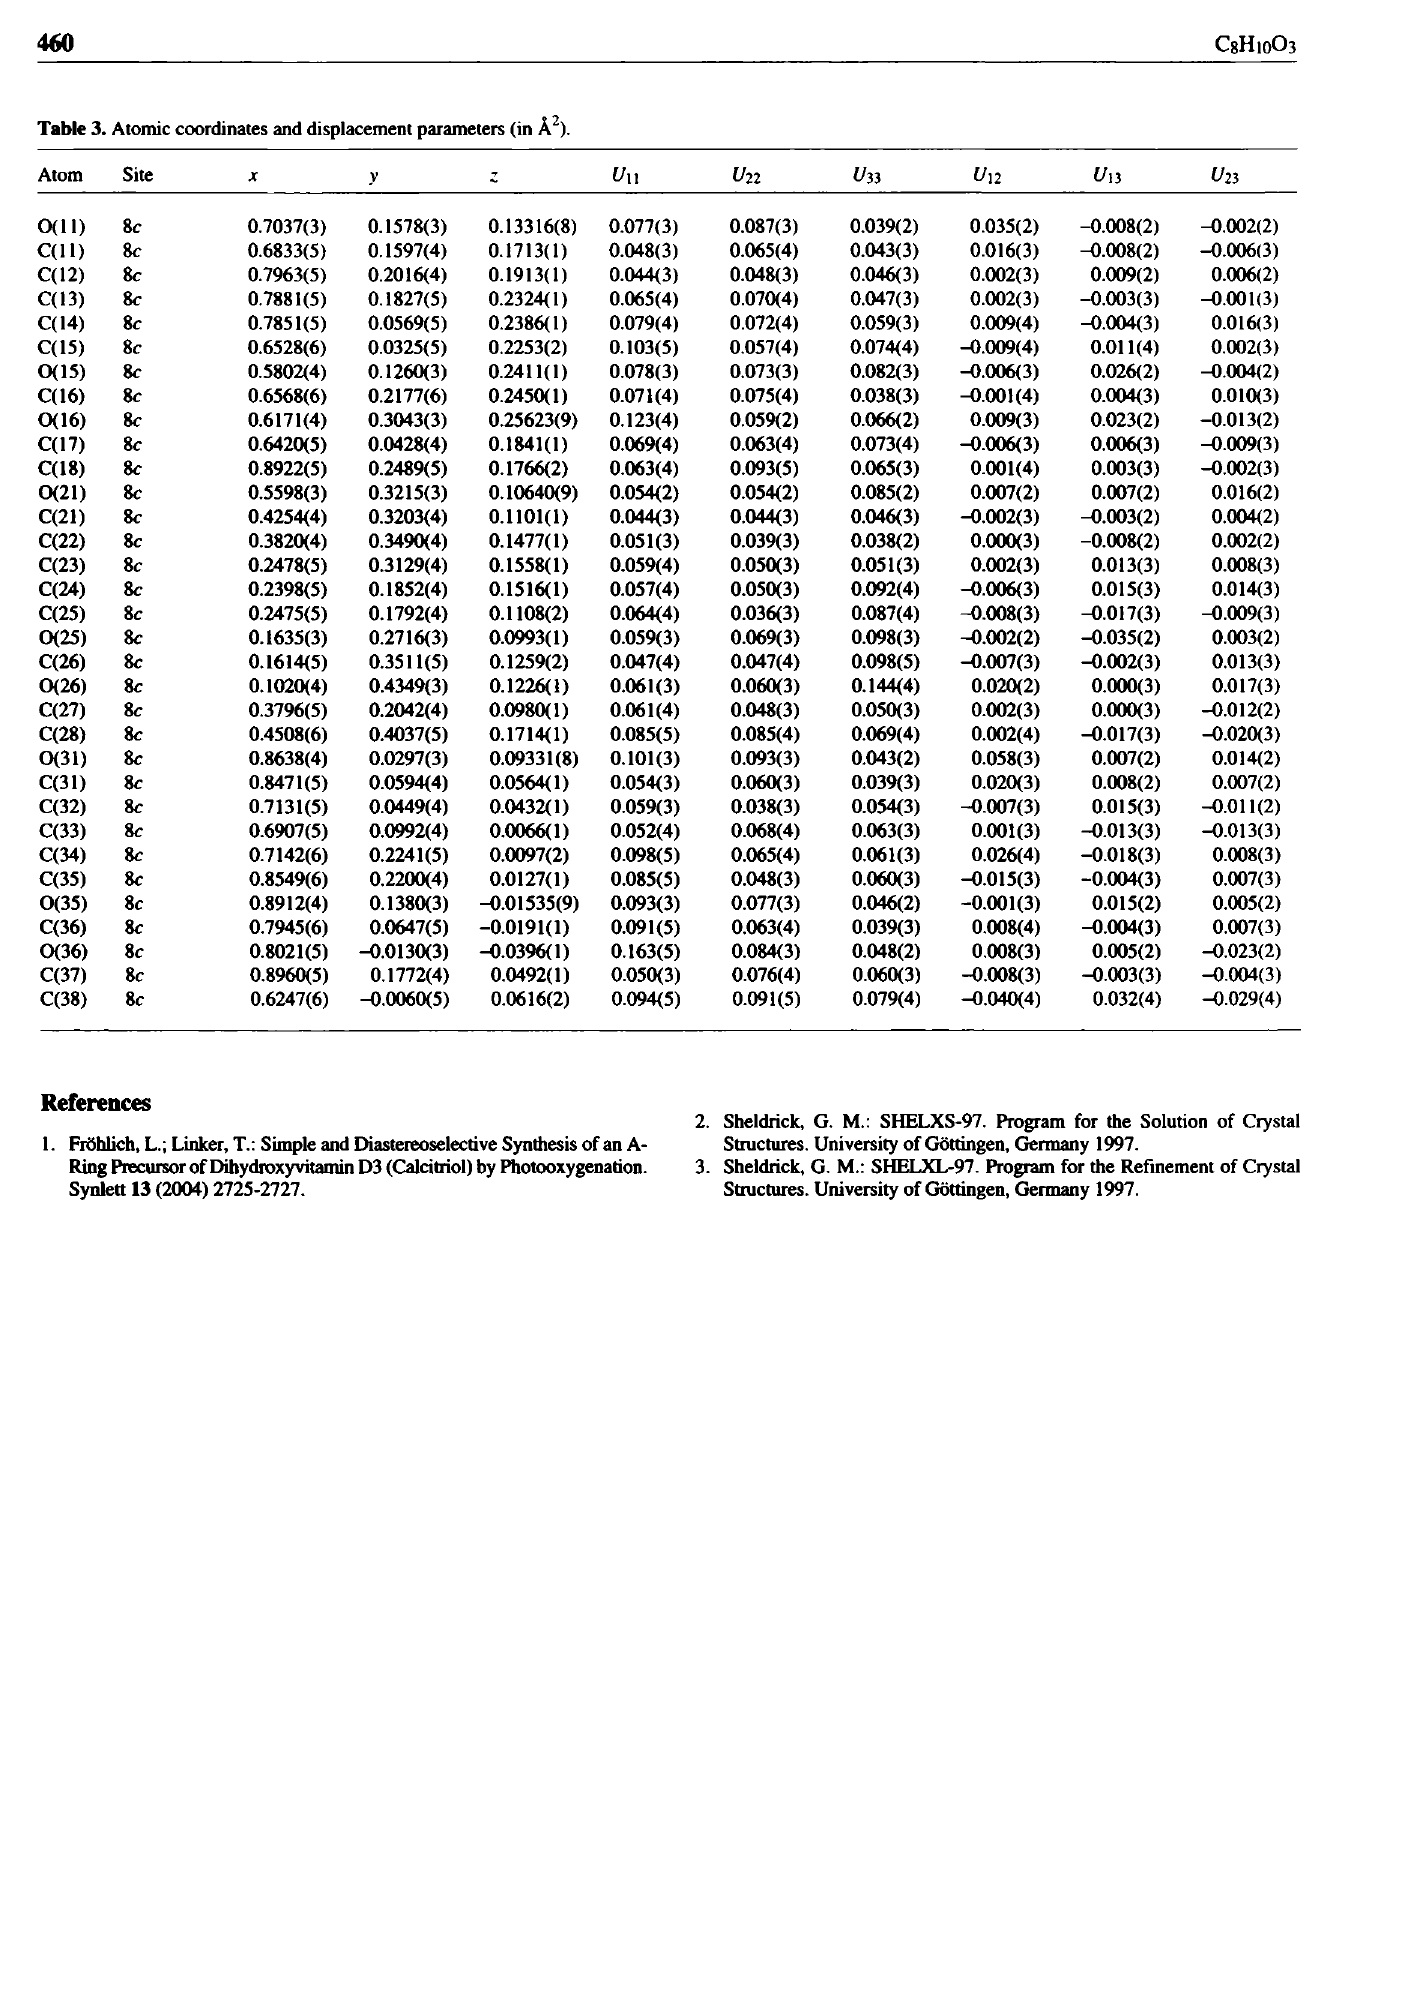
Table 3. Atomic coordinates and displacement parameters (in À 2